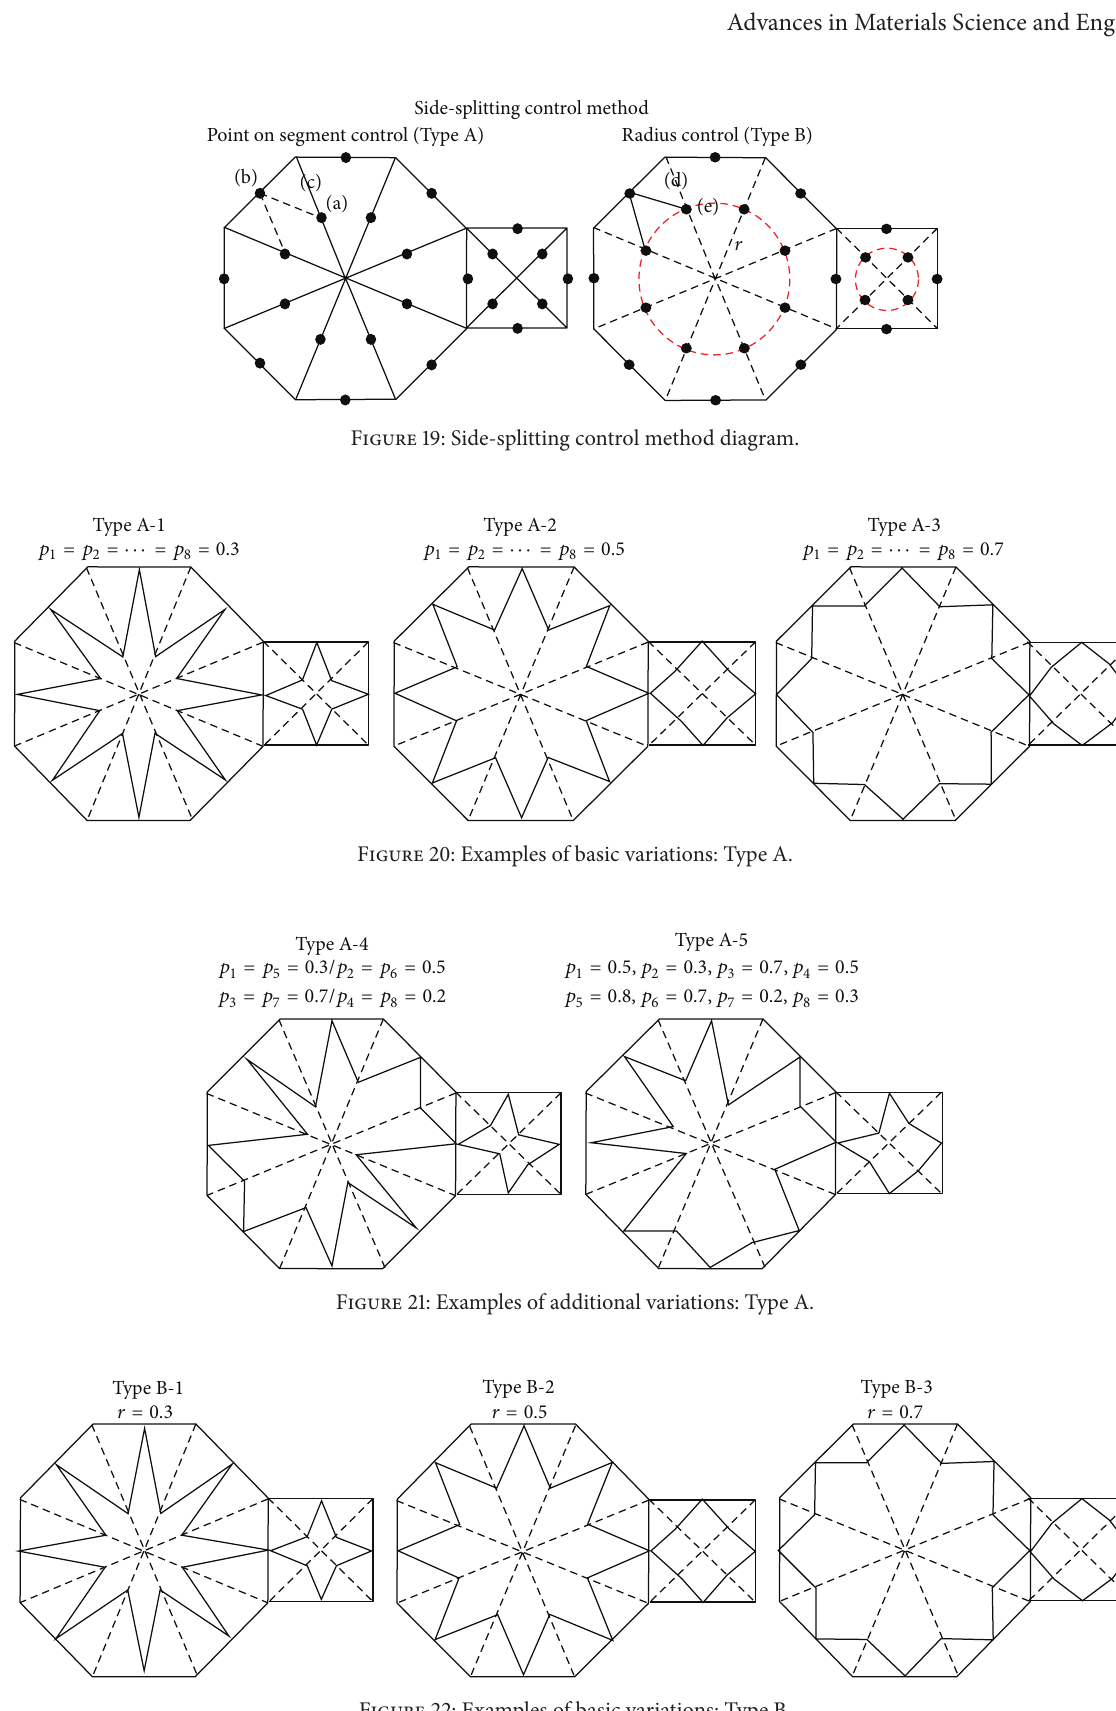
Figure 22: Examples of basic variations: Type